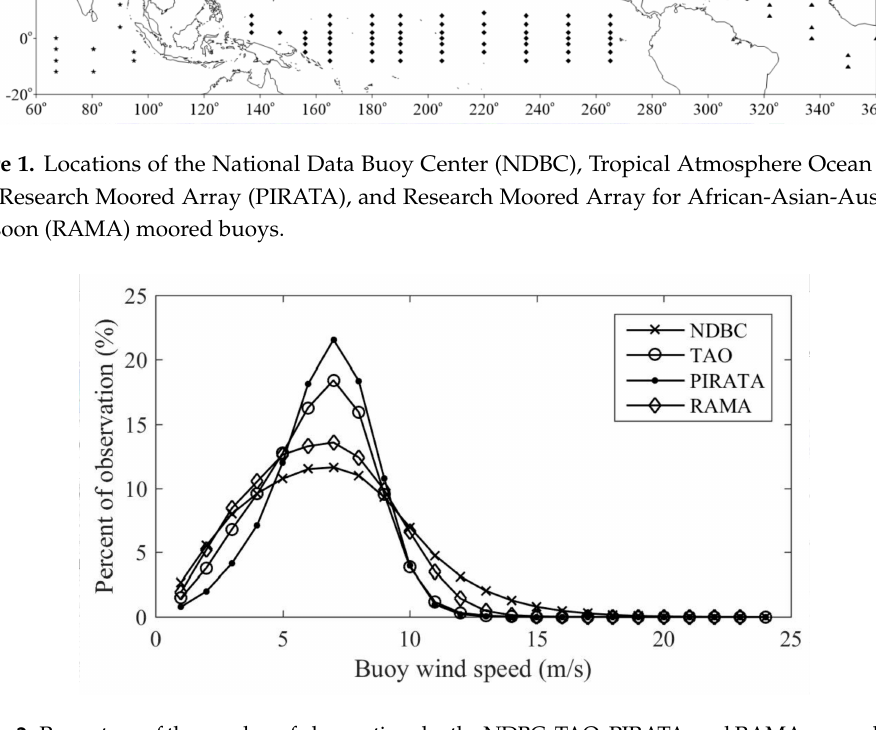
Figure 2. Percentage of the number of observations by the NDBC, TAO, PIRATA, and RAMA moored